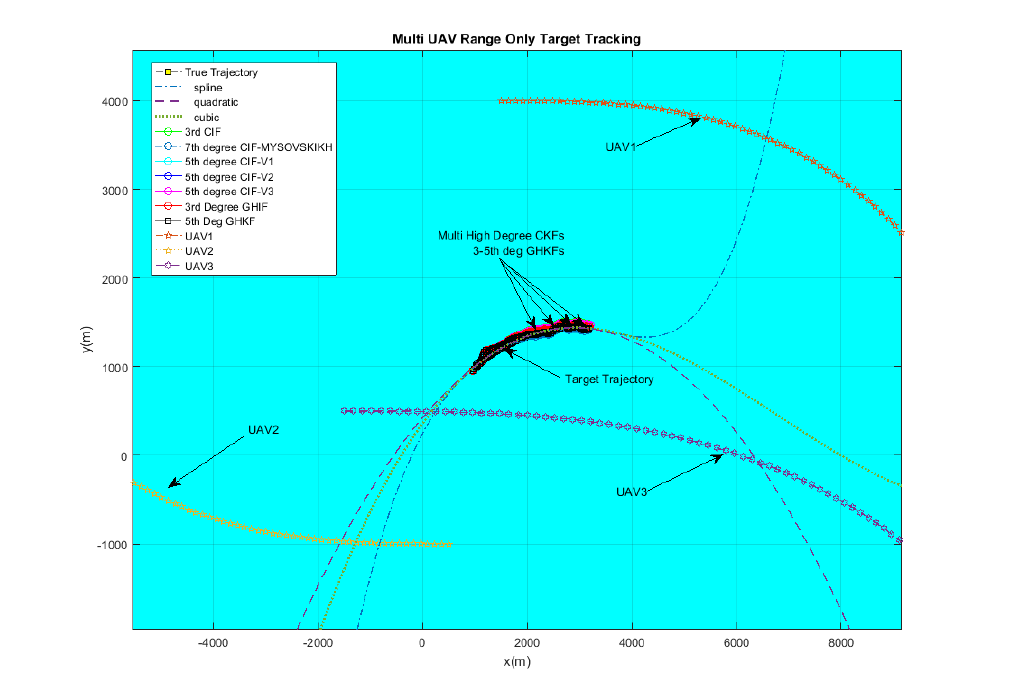
Figure 9. Range-only Doppler-based estimation: Results of 7 th -degree–5 th -degree/5 th -degree–3 rd -degree GHIF